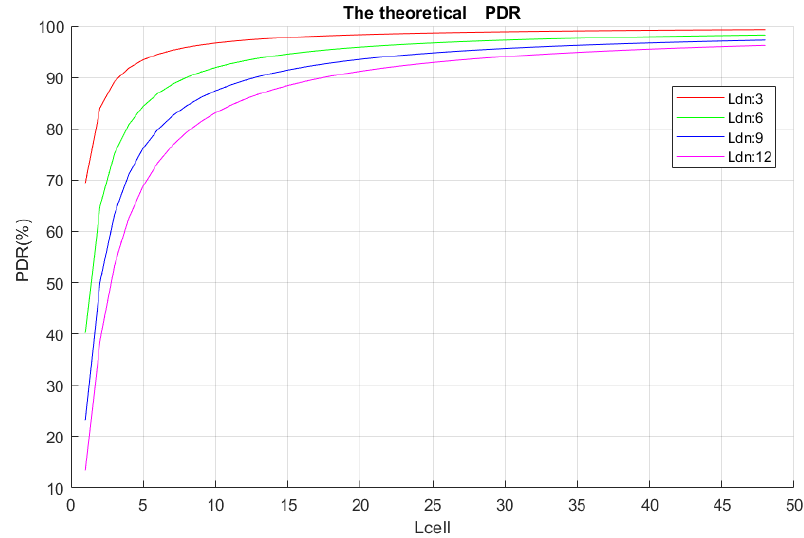
Figure 12. Theoretical performance of the PDR in function of L cell with N LnPerTx = 6.